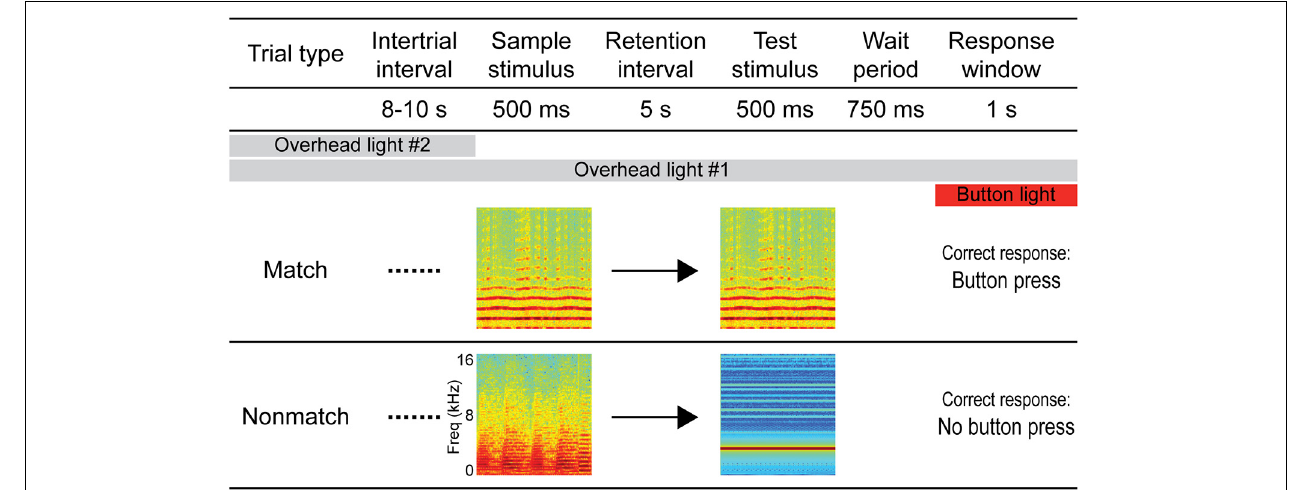
FIGURE 1 | Diagram of the auditory short-term memory task. Each trial consisted of 500-ms sample and test sounds separated by a 5-s retention interval. For match trials, the sounds were identical and the correct response was a button press, whereas for non-match trials the sounds were non-identical and the correct response was to withhold from pressing the button. Sample and test sounds were pseudorandomly selected for each trial from a variety of naturalistic and artificial sound exemplars (see Methods).